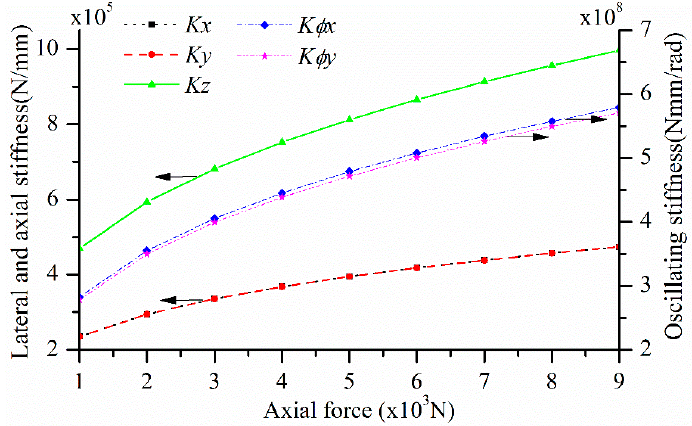
Figure 22. The global stiffness varying with different axial force.